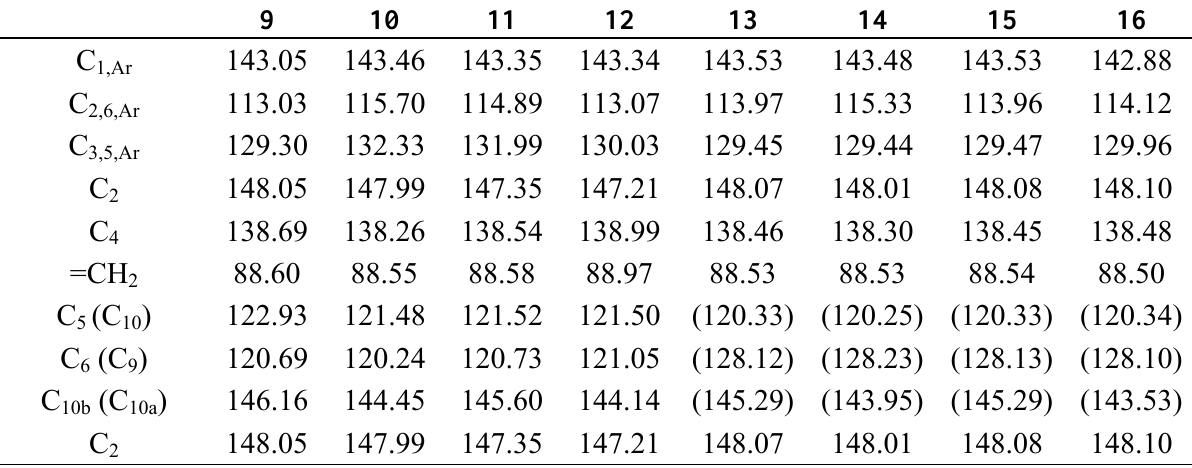
Table 4 . Partial 13 C-NMR data for 9-16 .